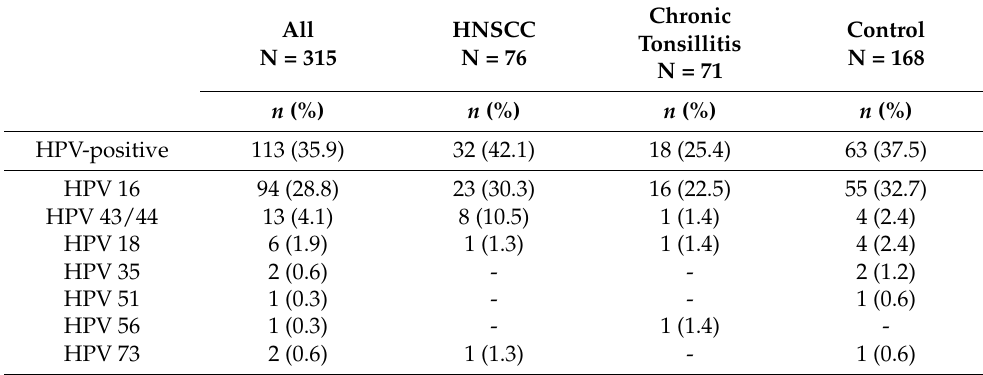
Table 2. The number of positive HPV results in all analyzed groups, considering all HPV variants. The percentages of HPV-positive results in each group are given in parentheses.